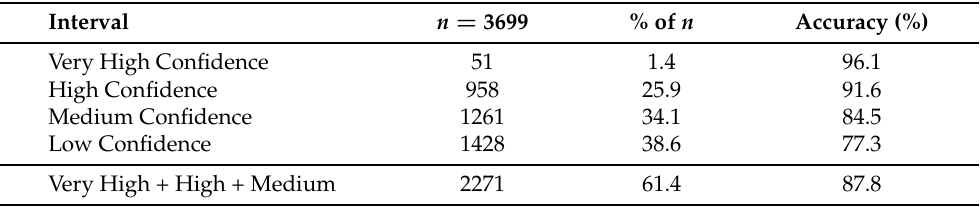
Figure 4. Comparison of five classification methods with two versions of the swarm (first and last columns) for the Hollywood movies dataset. Table 6. Confidence Interval Distribution and Accuracy—Meta-Swarm for Hollywood